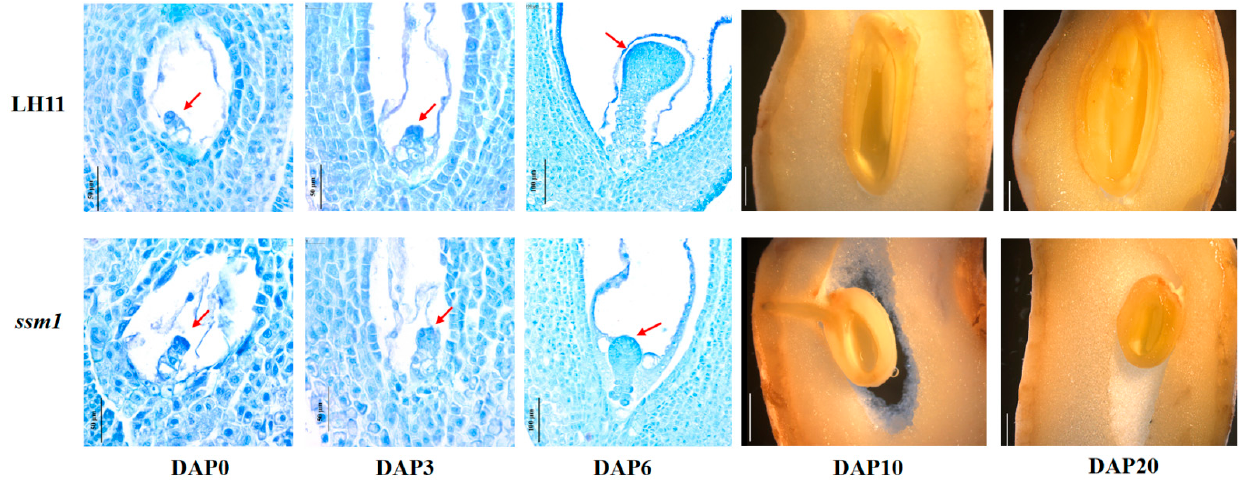
Figure 2. Early embryonic development differences between ssm1 and LH11. DAP0, 0 day after pegging; DAP3, 3 days after pegging; DAP6, 6 days after pegging; DAP10, 10 days after pegging; DAP20, 20 days after pegging. Red arrows represent embryos.